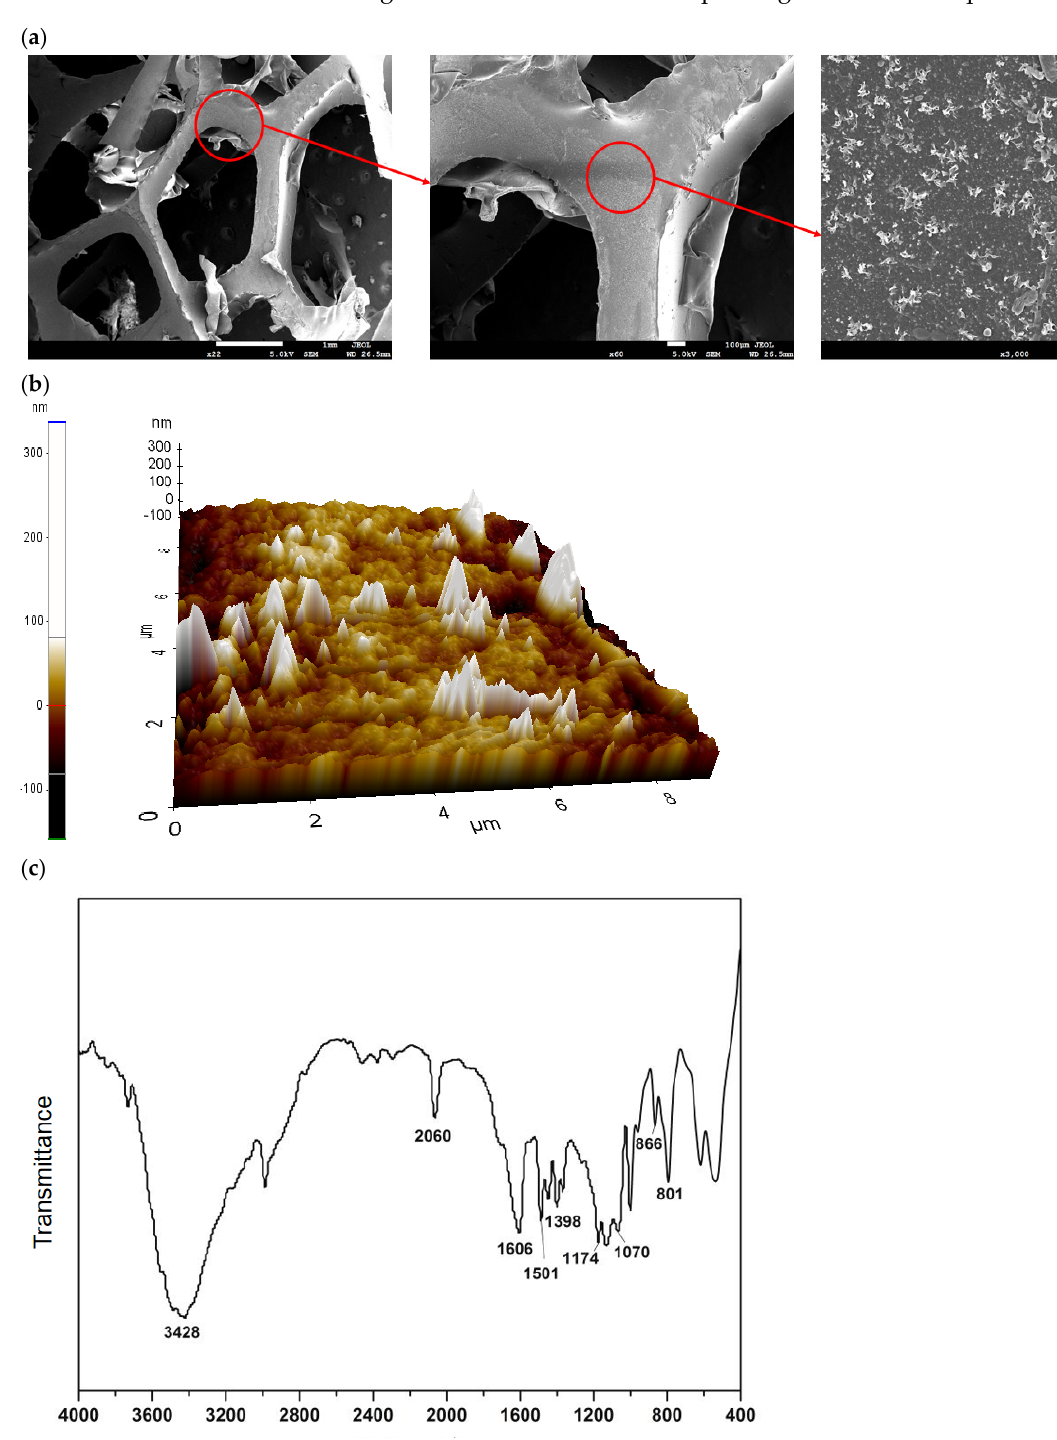
Figure 2. Characteristics of original bio ‐ carrier: ( a ) SEM observation; ( b ) AFM observation; ( c ) FTIR spectrum.